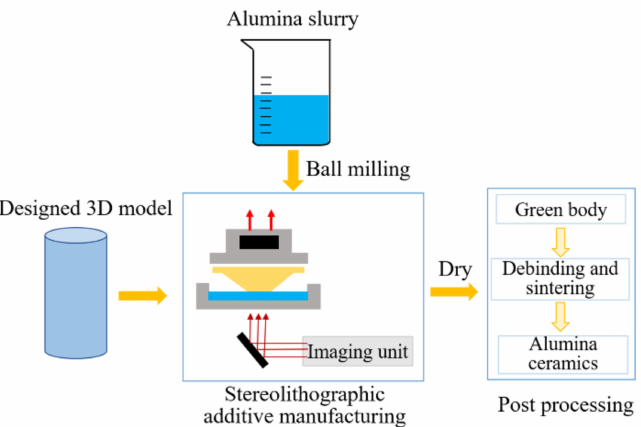
Figure 1. Schematic for the preparation of additively manufactured Al 2 O 3